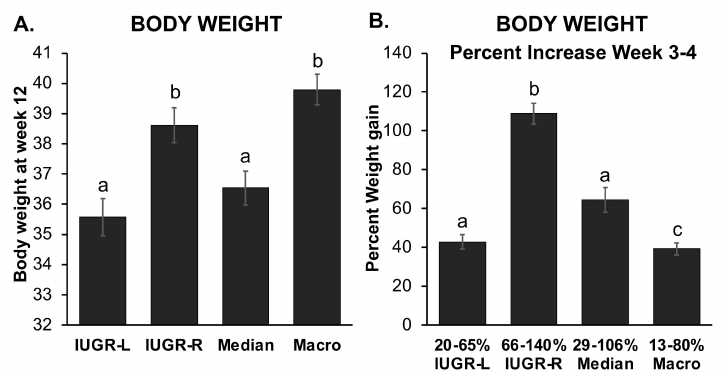
Figure 3. Body weight and percent growth of IUGR-L ( n = 13), IUGR-R ( n = 16), median ( n = 17) and macrosomic ( n = 21) males. ( A ) body weights at week 12, when IUGR-L and median males weighed less than IUGR-R and macrosomic males. ( B ) the percent postweaning (week 3–4) weight gain, showing that IUGR-R males exhibited the most rapid post-weaning weight gain, while macrosomic males showed the lowest week 3–4 percent weight gain. Groups with different letters above the error bar are significantly different from each other; groups that share a letter in common are not statistically different. Values are mean ±